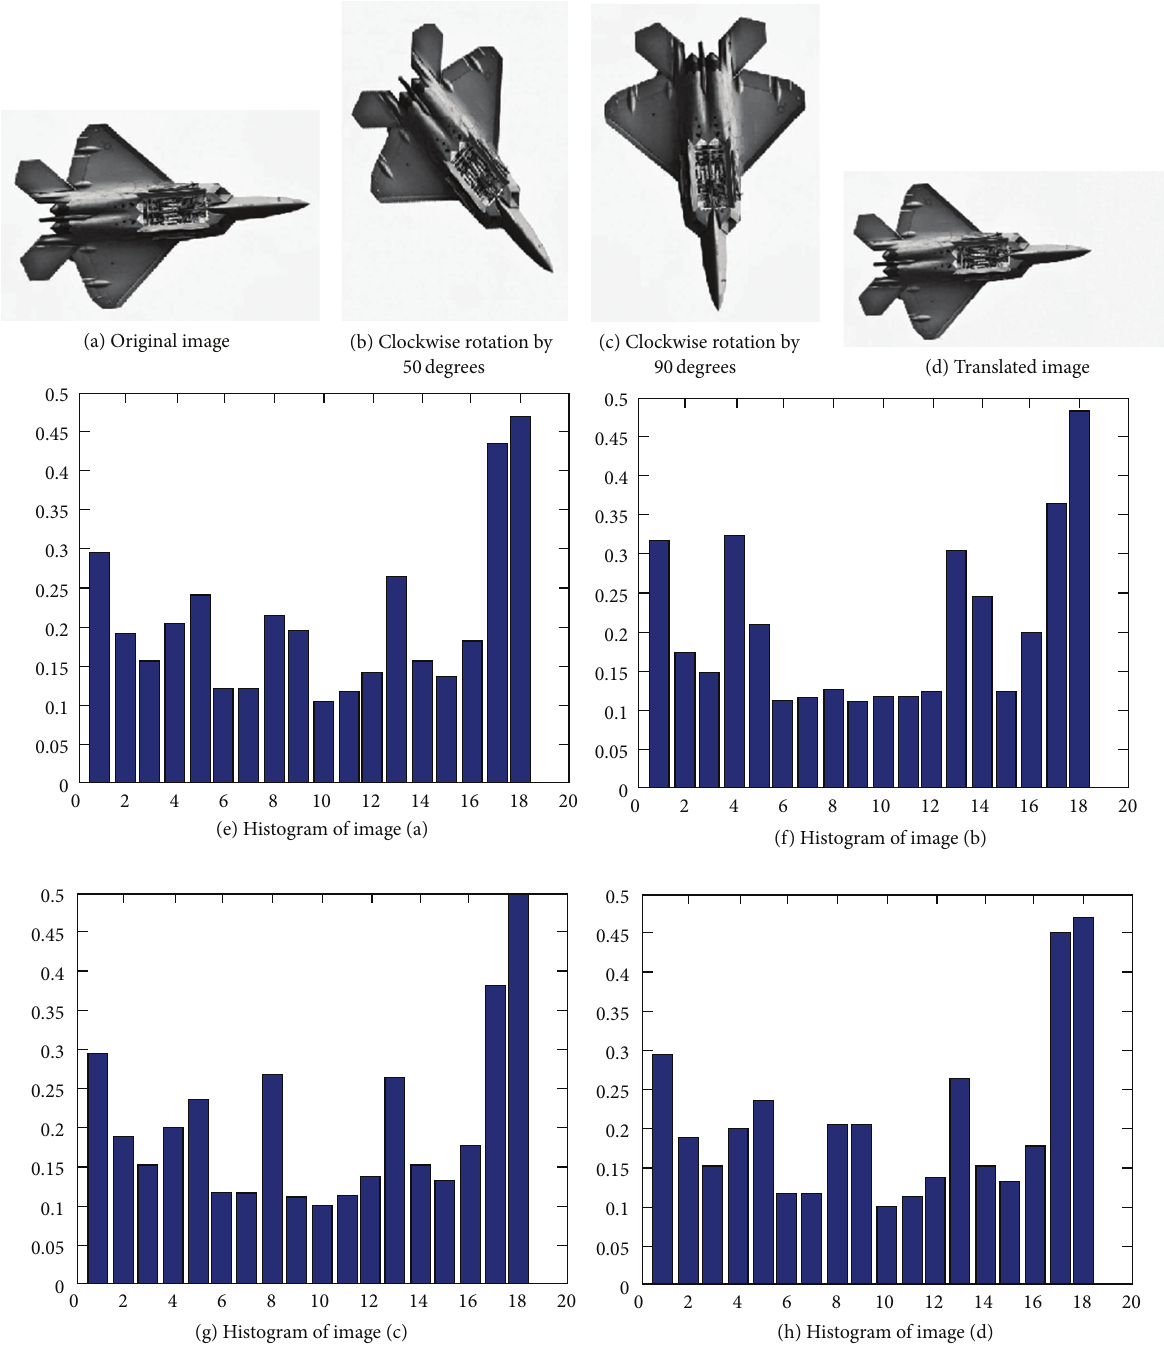
Figure 6: The effects of image rotation and translation on EGOSC.